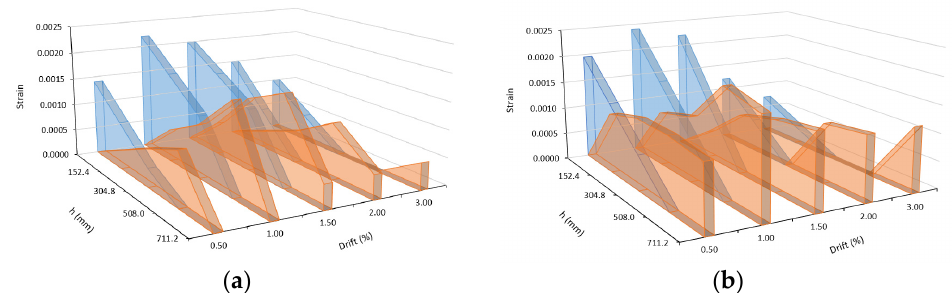
Figure 9. Strain distribution of ( a ) corner and ( b ) middle bars of column S20MI (based on [107]).